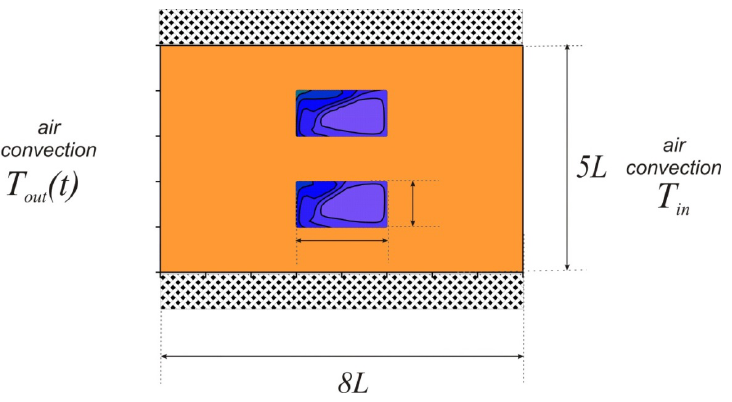
Figure 1. The considered model.